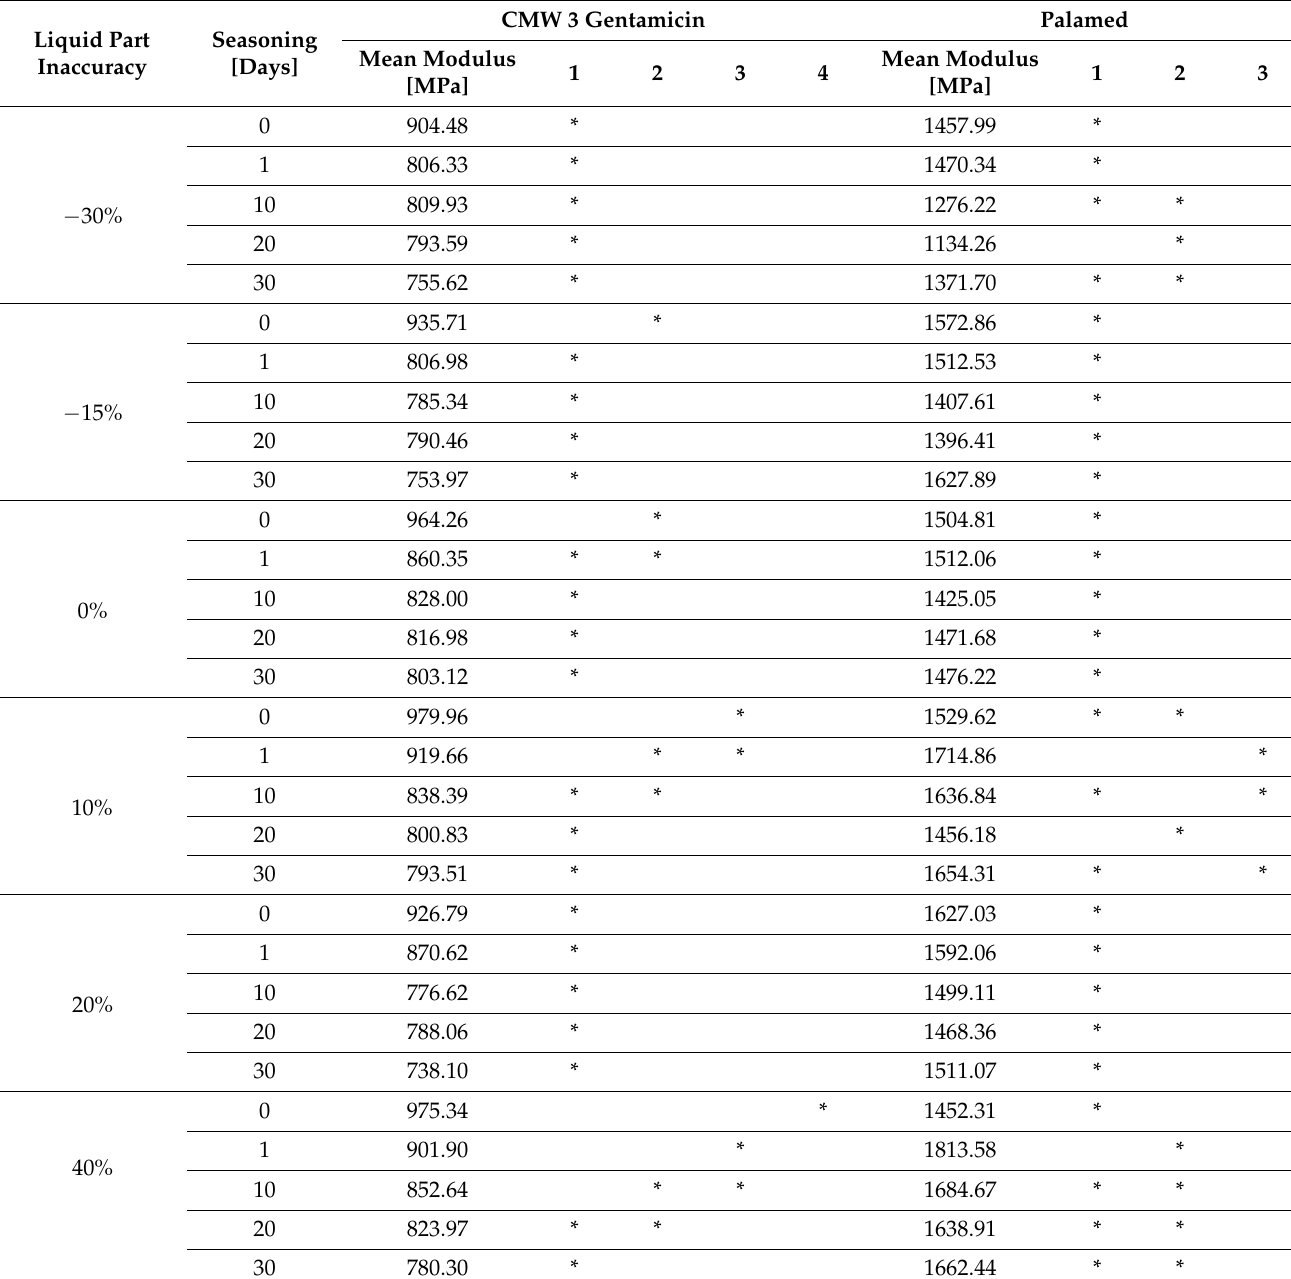
Table 4. Results of statistical analysis of compression modulus test results (*—samples within homogeneous